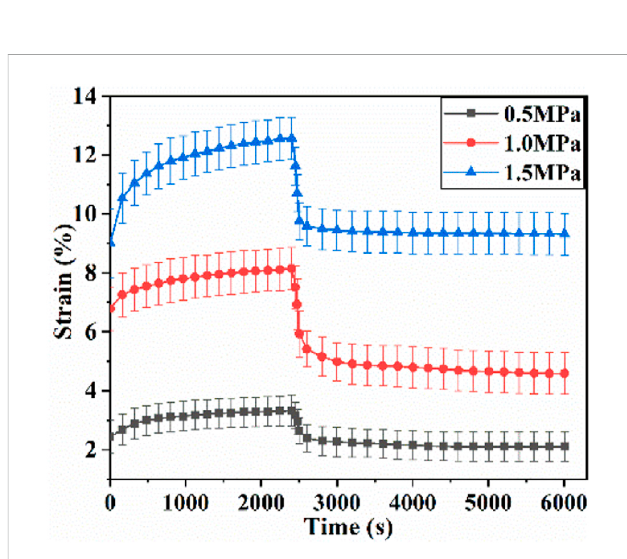
FIGURE 6 Biaxial creep-recovery curves of articular cartilage at different stress